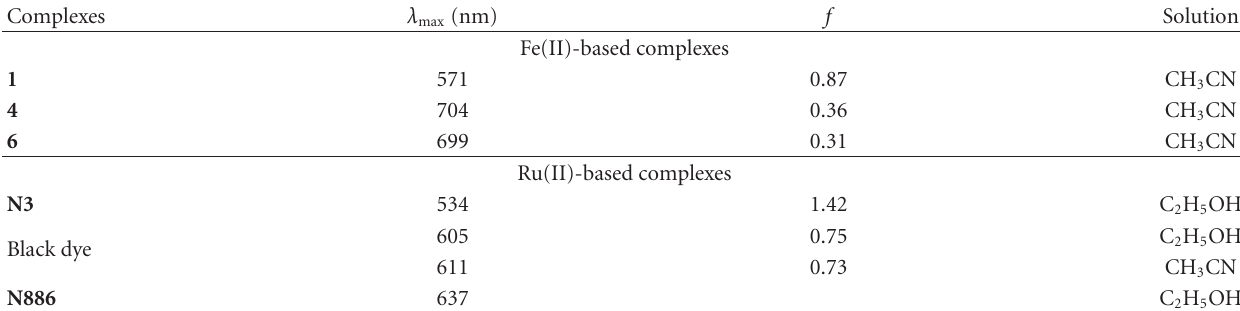
Table 4: Selected absorption spectral properties of Fe(II)-based complexes (1, 4, and 6) and Ru(II)-based complexes (N3, black dye, and N886) in di ff erent organic solvents a,b